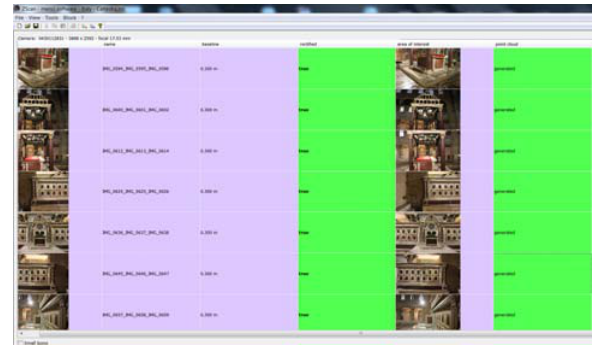
Figure 8. The window of the